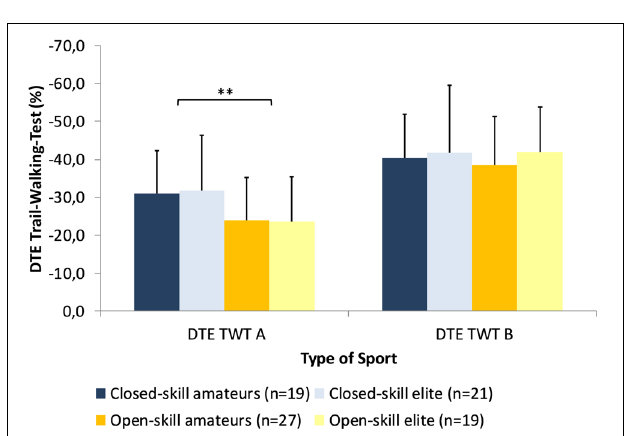
FIGURE 4 | Trail-Making-Test (mean, SD), and DTEs across athletes from closed- and open-skills sports.